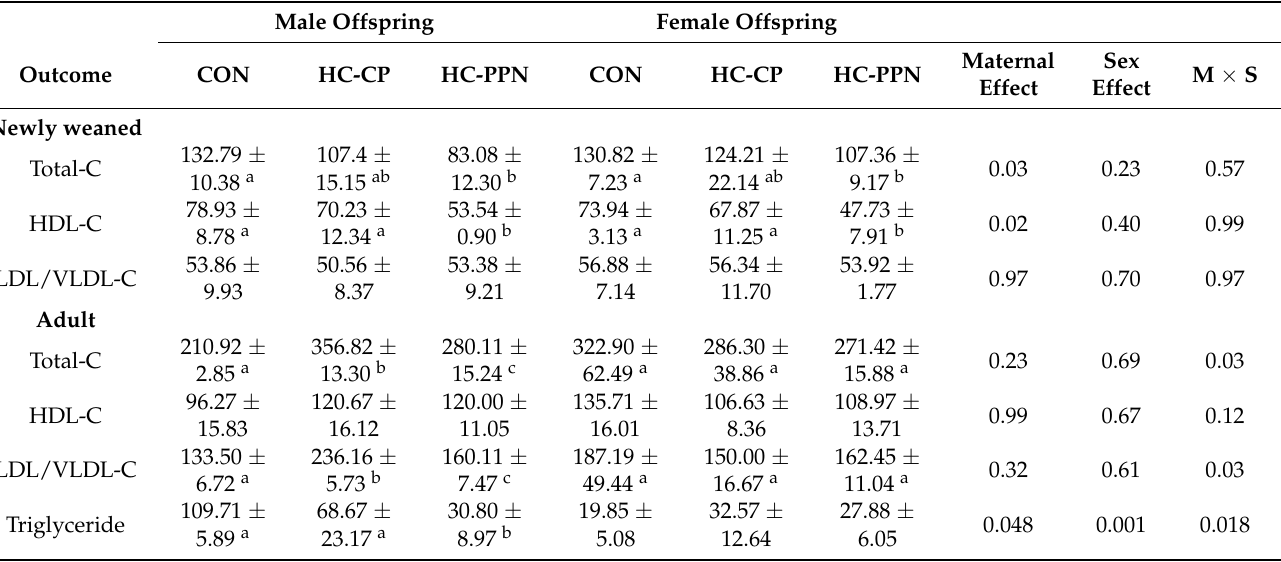
Table 3. Serum lipid profiles (mg/dL) in male and female newly weaned and adult offspring. Male Offspring Female Offspring HC-PPN HC-PPN